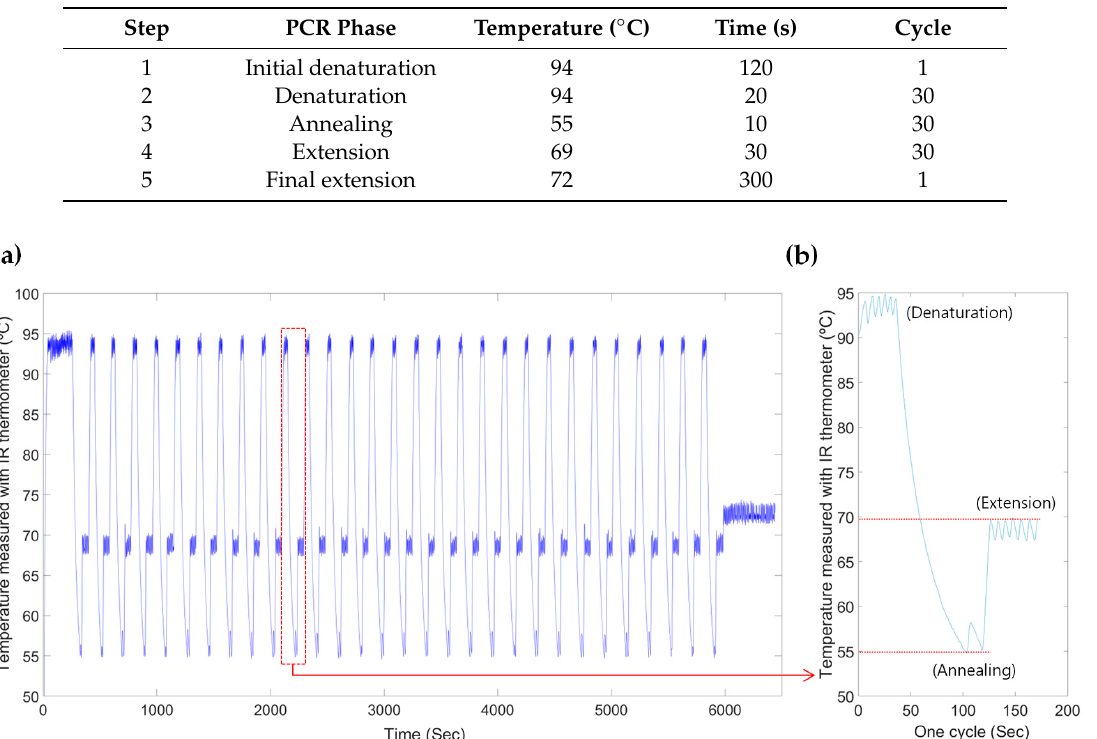
Table 1. Thermal cycle temperatures for PCR amplification on PCR–LOD.